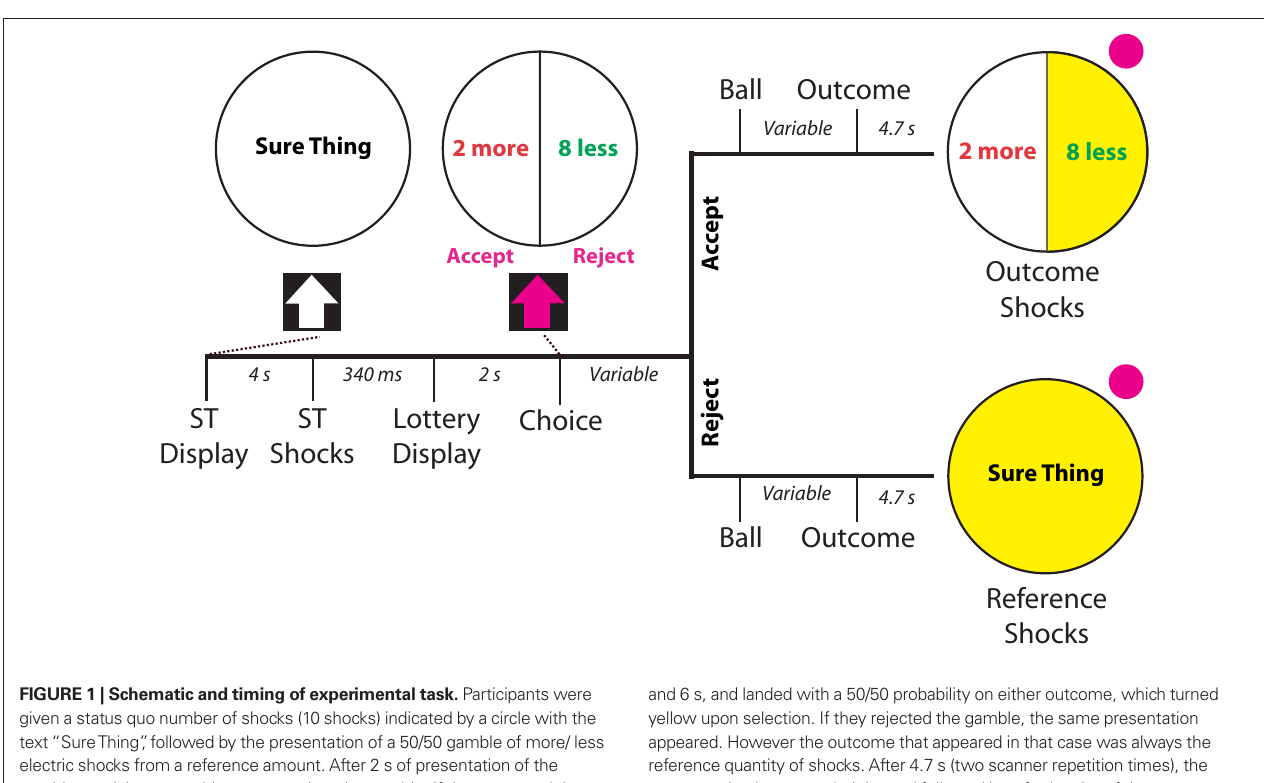
FIguRe 1 | Schematic and timing of experimental task. Participants were given a status quo number of shocks (10 shocks) indicated by a circle with the text “Sure Thing”, followed by the presentation of a 50/50 gamble of more/ less electric shocks from a reference amount. After 2 s of presentation of the gamble, participants could accept or reject the gamble. If they accepted the gamble, a pink ball flipped between outcomes for a period varying between 3